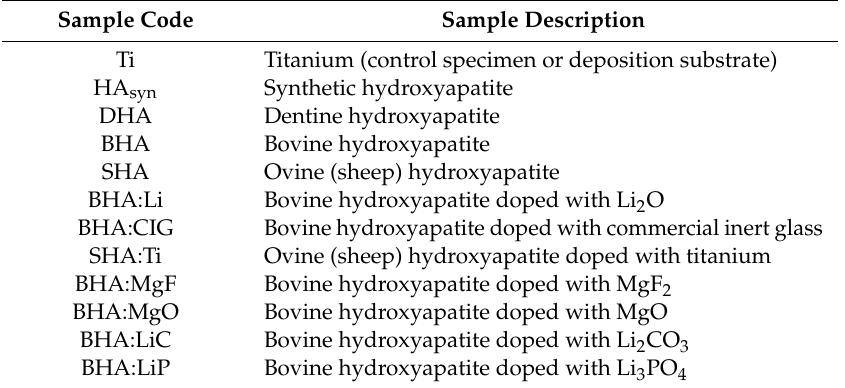
Sample acronyms related to di ff erent materials used throughout the review and their